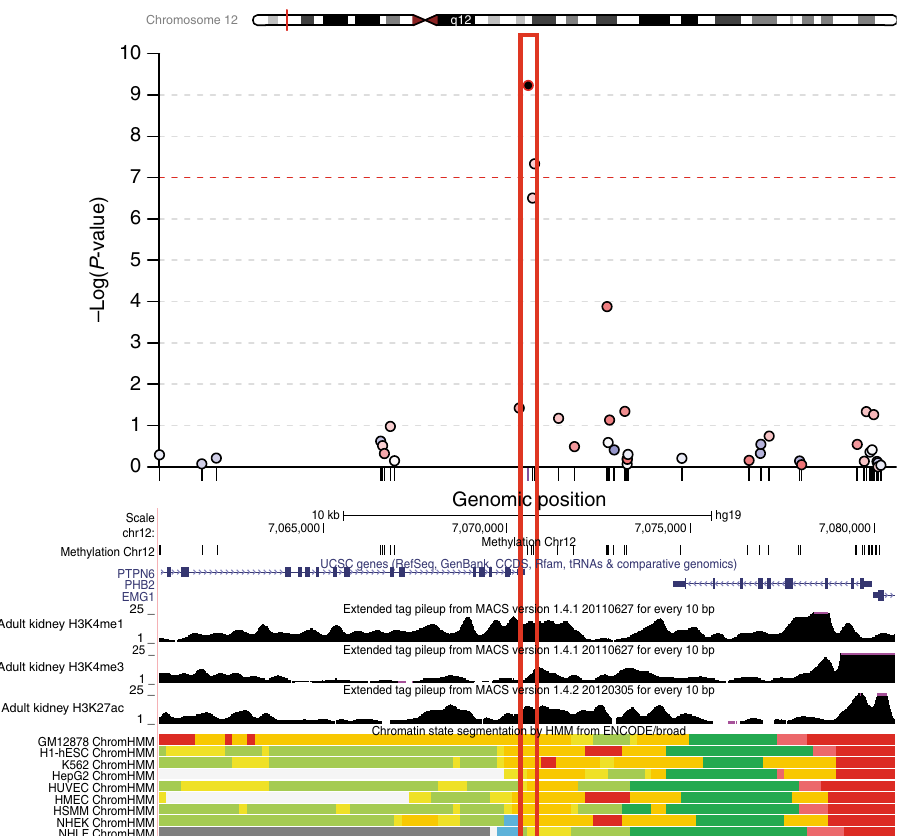
Fig. 2 Regional association plot and genomic annotation surrounding the index cg19942083 CpG site on chromosome 12p13. Y -axis: -log 10 ( P -values) for association between methylation and eGFR from a combined analysis of ARIC and FHS; x -axis: chromosomal position. Each dot represents an evaluated CpG, the color-coding re fl ects the degree of correlation of methylation values at all other CpGs with that of the index site (red: positive correlation, blue: negative correlation). The index probe cg19942083 is represented as a black dot and included in a red box to facilitate mapping across annotation tracks. Chromatin annotation from various tissues and histone modi fi cation marks from kidney cells (black tracks) show that the index probe maps into an active enhancer in kidney tissues. H3K4me1 marks represent poised enhancer elements, H3K4me3 marks represent transcription start sites for actively transcribed genes, and H3K27ac marks represent active enhancer elements. Chromatin annotation track color-code: dark red: active promoter, light red: weak promoter, dark green: transcriptional transition/elongation, light green: weak transcribed, yellow: weak/poised enhancer, orange: strong enhancer, blue: insulator, gray: repressed polycomb, light gray: heterochromatin;low signal;repetitive/CNV. Chromatin annotation tracks were evaluated from 9 different cell lines from the ENCODE Project: B-lymphoblastoid cells (GM12878), embryonic stem cells (H1 hESC), erythrocytic leukemia cells (K562), hepatocellular carcinoma cells (HepG2), umbilical vein endothelial cells (HUVEC), mammary epithelial cells (HMEC), skeletal muscle myoblasts (HSMM), normal epidermal keratinocytes (NHEK), and normal lung fi broblasts